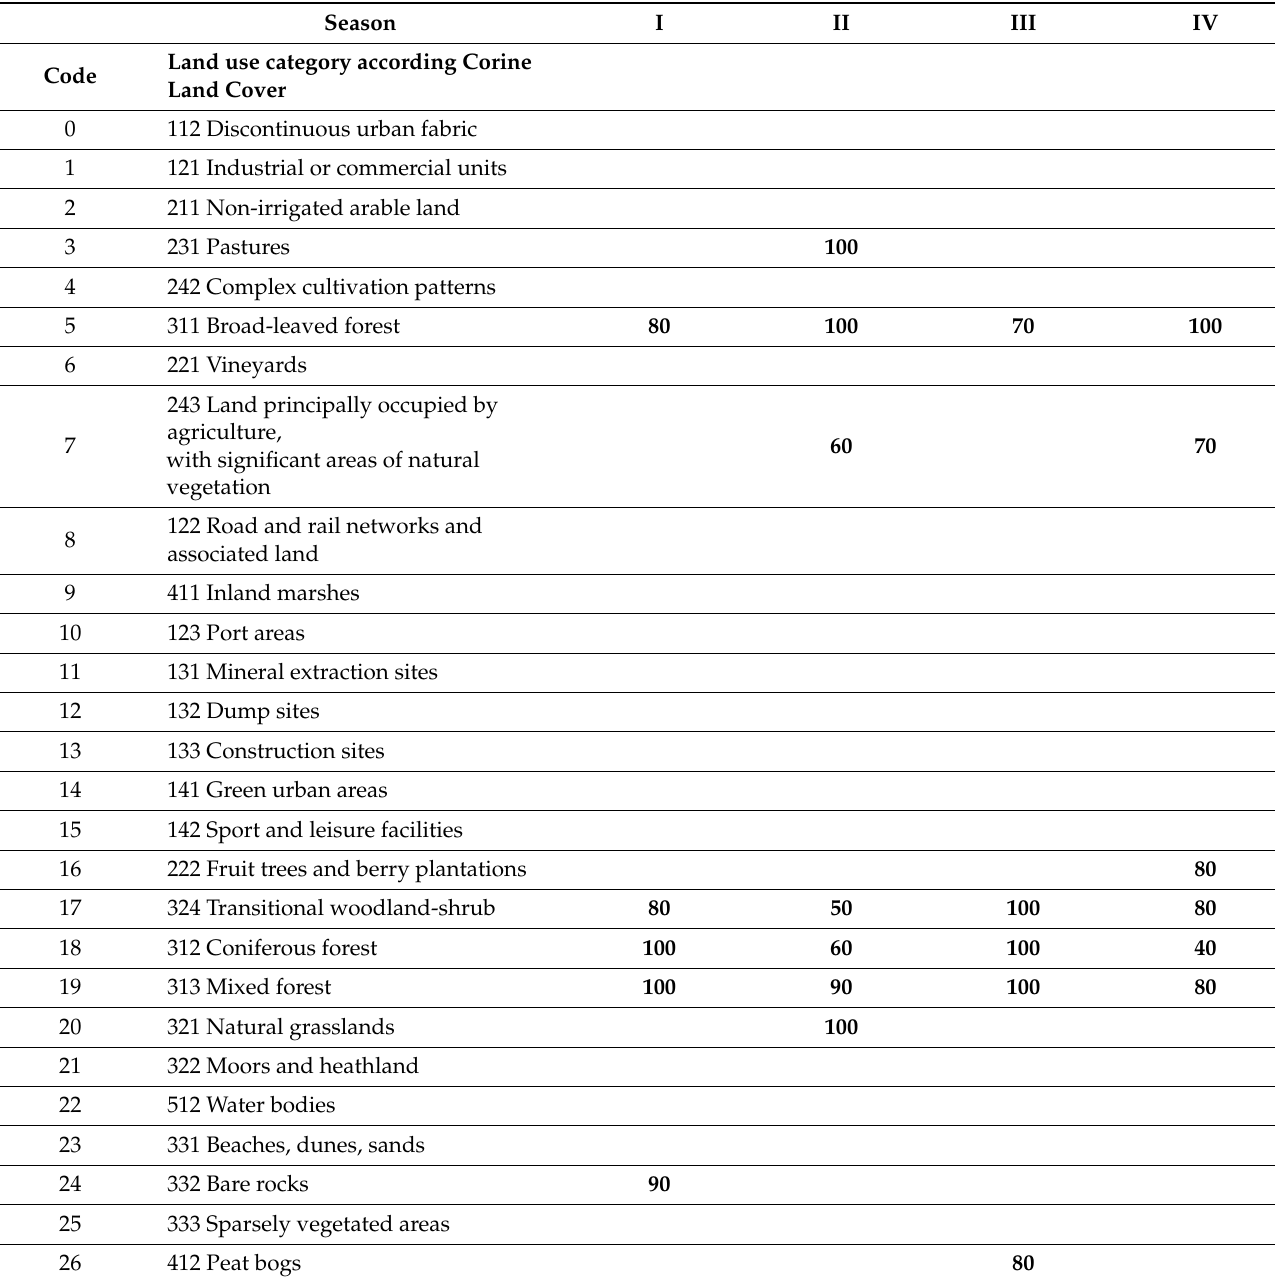
Table 4. Parameterization of habitat factors-land use